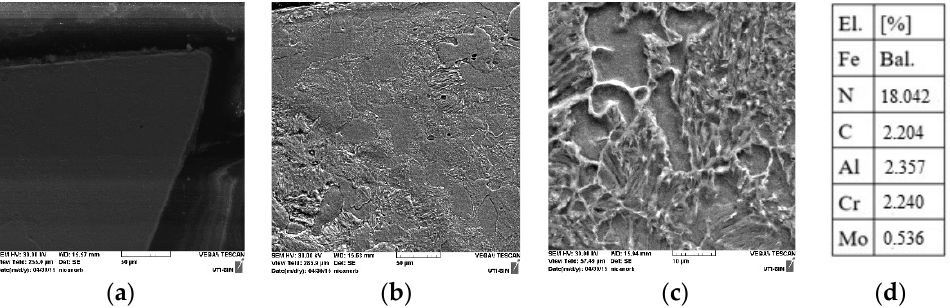
Figure 6. No screen nitrided sample SEM micrographs, 60° area B, different scale: ( a ) 50 µm, ( b ) 50 µm, ( c ) 10 µm, and ( d ) mass concentration of elements per area.